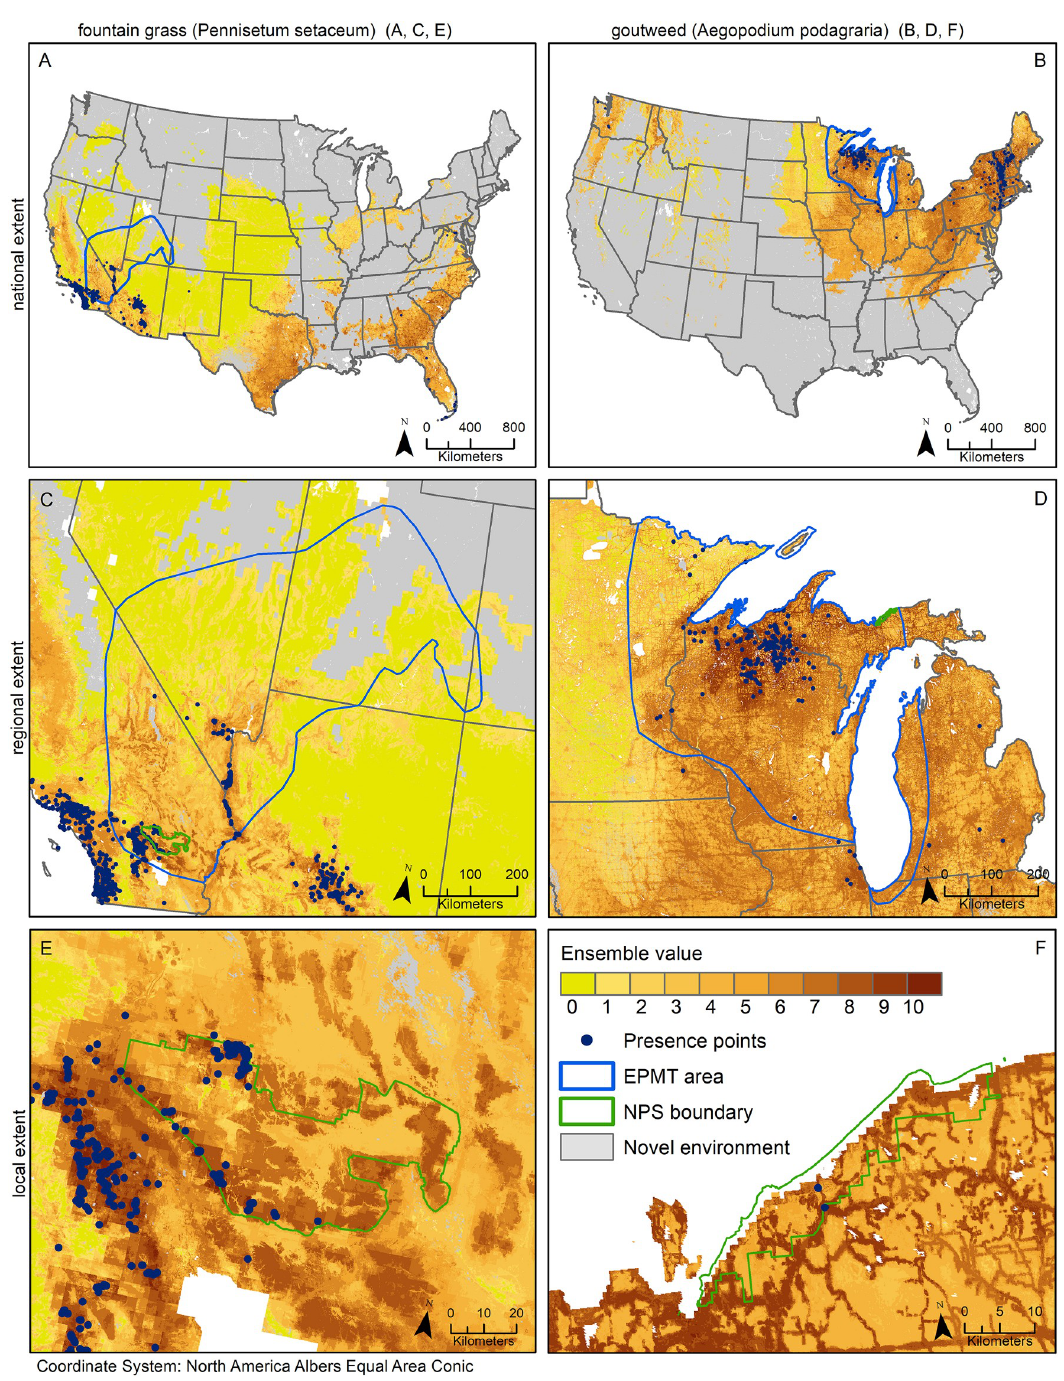
Fig 2. A-F: Potential habitat suitability model ensemble (maximum value of 10) using the one percentile threshold for fountain grass ( Pennisetum setaceum ) (A,C,E) and goutweed ( Aegopodium podagraria ) (B,D,F) at each extent: national extent (A, B), regional extent defined by the Exotic Plant Management Team Regions including C) Lake Mead and D) Great Lakes), and the local extent defined by E) Joshua Tree National Park and F) Pictured Rocks National Lakeshore.